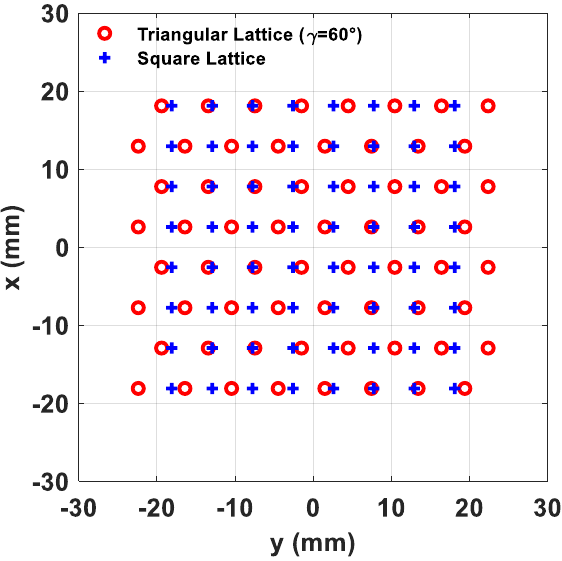
Figure 7. Array geometry of a planar array of 64 elements (8 × 8) in a triangular lattice ( γ = 60 ◦ ) and a square lattice.